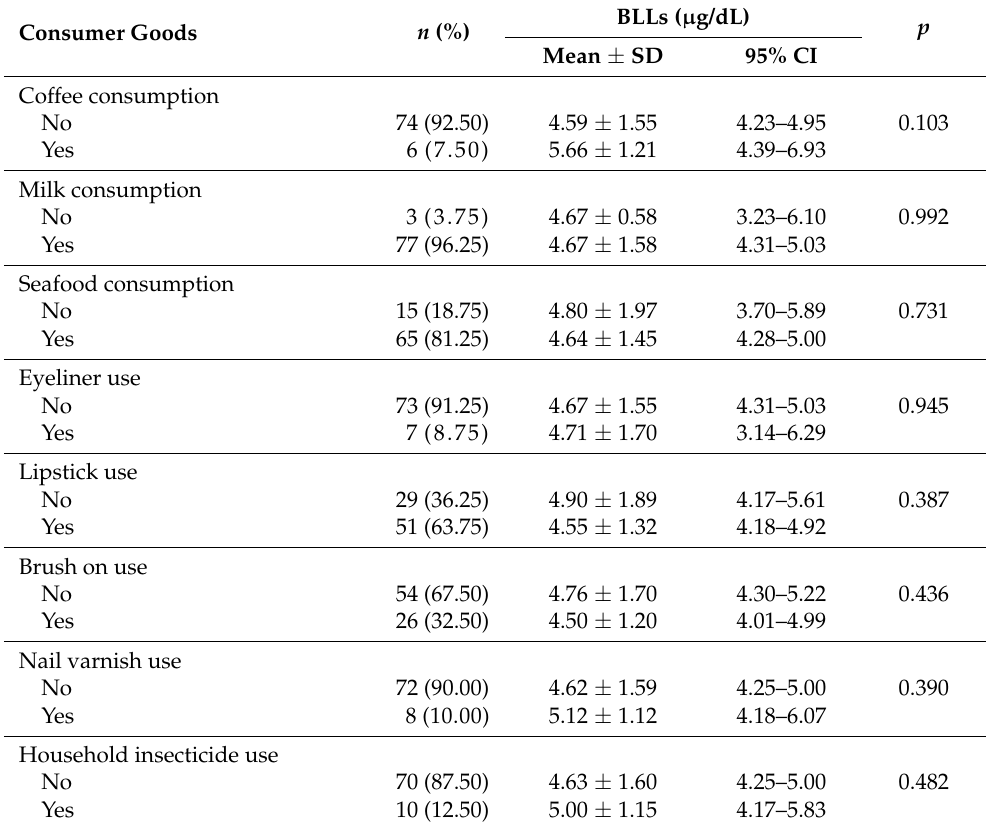
Table 2. The consumer goods of pregnant women (in the past month) and mean, 95% CI for BLLs ( n = 80).